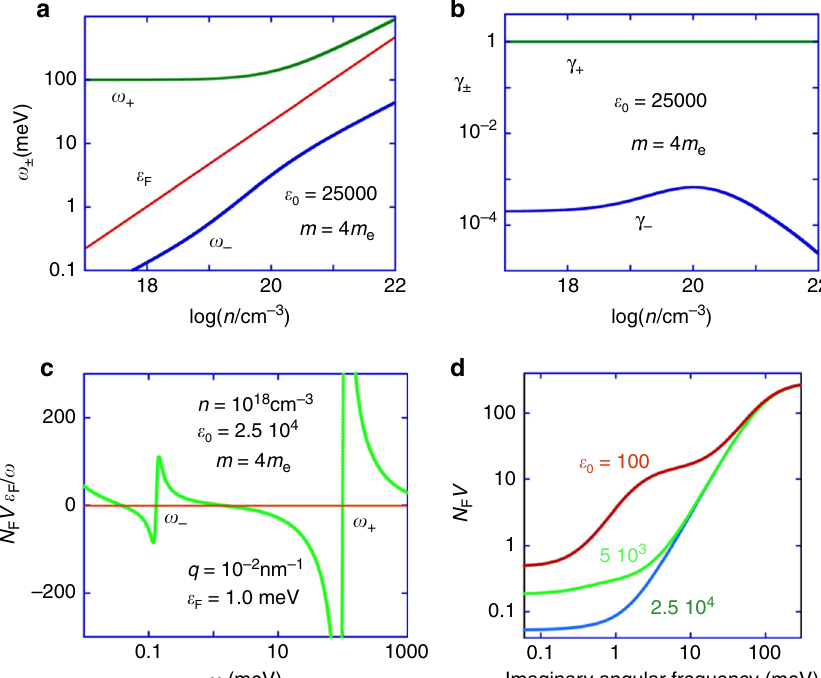
Fig. 3 The calculated longitudinal hybrid polar optical frequencies and effective interaction between doped carriers for SrTi 1- x Nb x O 3 (Nb-doped SrTiO 3 ). a , b The longitudinal hybrid frequencies ω ± ( q ), Fermi energy, ε F , and coupling functions γ ± ( q ) vs. carrier density, n , de fi ned by Eqs. (1) – (3) and materials parameters relevant to SrTiO 3 (see “ Methods ” section) ℏ = k B = 1). c The normalized effective interaction N F V ( q , ω ) ε F / ω vs. ω for